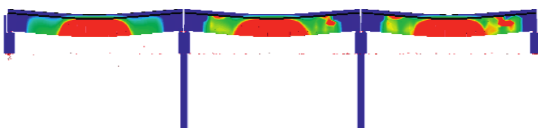
Figure 29: Principal normal strain at the end of the analysis, model